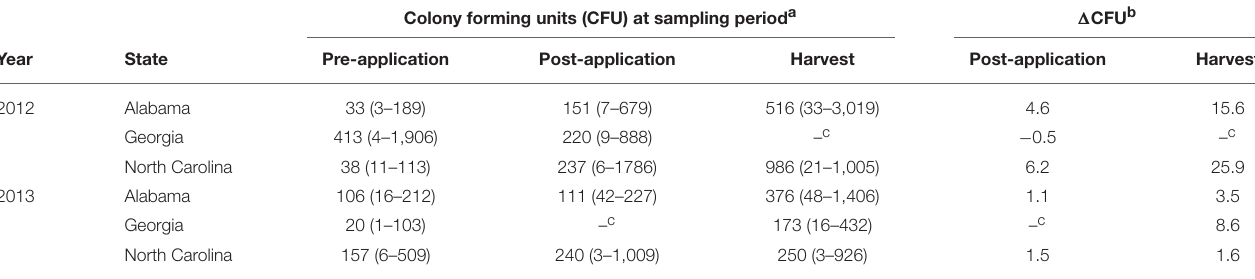
TABLE 2 | Population densities of Aspergillus section Flavi in soil from fields in the southeastern United States treated with Afla-Guard and AF36 biocontrol strains. Colony forming units (CFU) at sampling period a 1 CFU